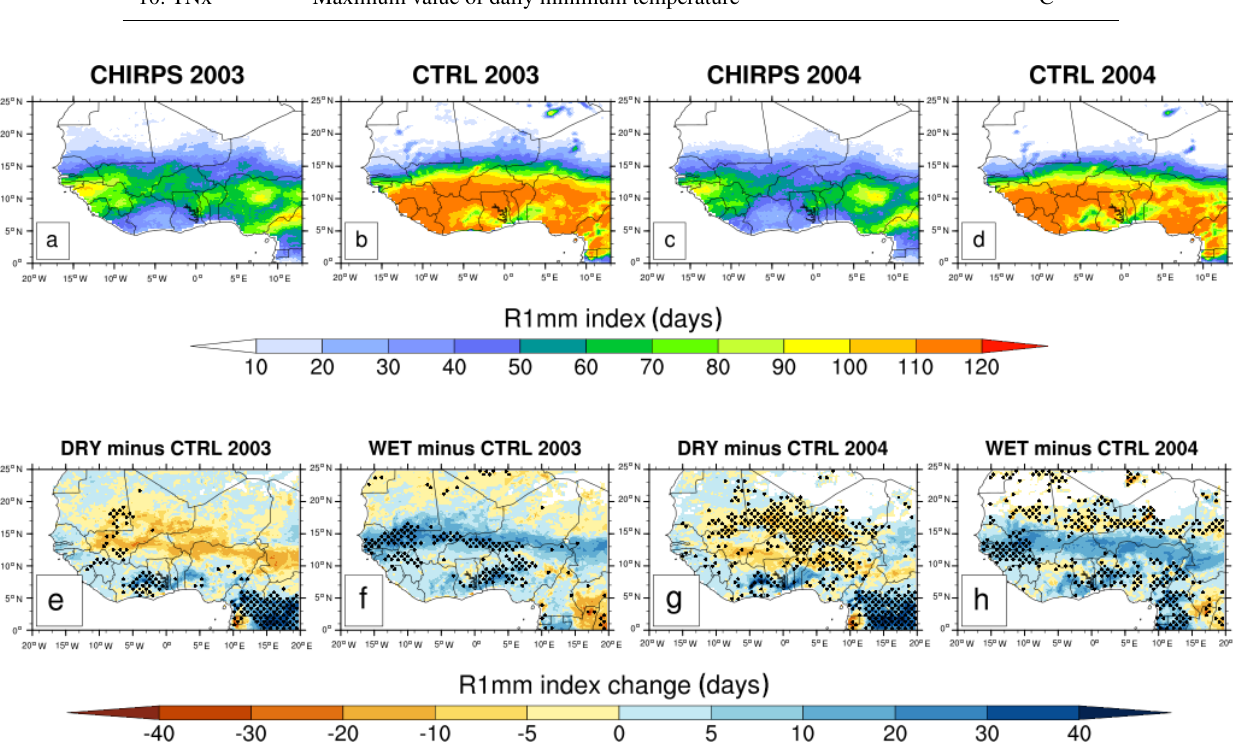
Figure 2. Mean values of the number of the wet days (R1mm index in days) from CHIRPS (a, c) observations for JJAS 2003 and JJAS 2004 and the simulated control (CTRL) experiments (b, d) initialized with initial soil moisture values from the ERA-20C reanalysis (top row) and changes in R1mm index in days (bottom row) for JJAS 2003 and JJAS 2004, from dry (e, g) and wet (f, h) experiments with respect to the control experiments. Areas with values passing the 95% significance test are